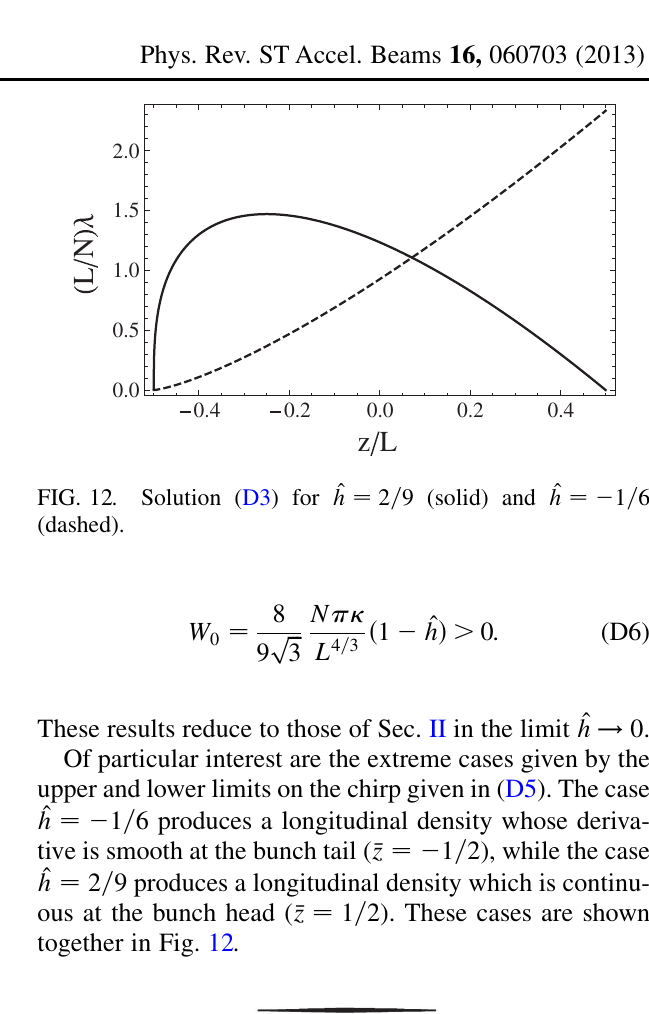
^ h ¼ 2 = 9 (solid) and